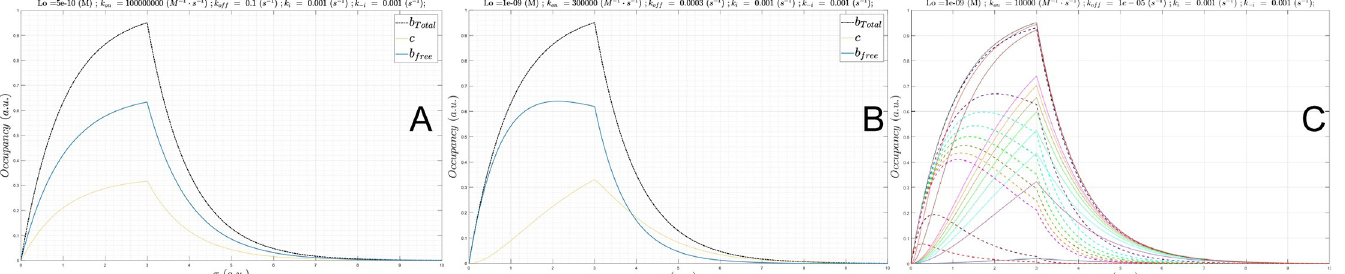
Fig 17. (A) Plot of B total ( τ ) (black), B free ( τ ) (blue), and c ( τ ) at L 0 = 0.5 � K d = 0.5 nM and Λ = 5 min ( k i = k − i = 1x10 -3 s -1 , k = 1x10 8 M -1 s -1 (gold). (B) Same as A, except at L 0 = K scenario in A reaches ~c 31 at all instants of time (an example of kinetically tuned binding), whereas the nSSO scenario results in considerably greater B free ( τ ) prior to c max (an example of non-kinetically tuned binding). (C) Plot of B total ( τ ) (gray), c ( τ ) at K d = 1 nM, Λ = 5 min ( k i = k − i = 1x10 -3 s -1 , k = 1x10 4 M -1 s -1 , in which L 0 was sampled between 1 nM and 2 μ M (solid lines), and B and k on compensated at sufficiently high L 0 , which in this case, approaches SSO conditions at L 0 = 1 μ